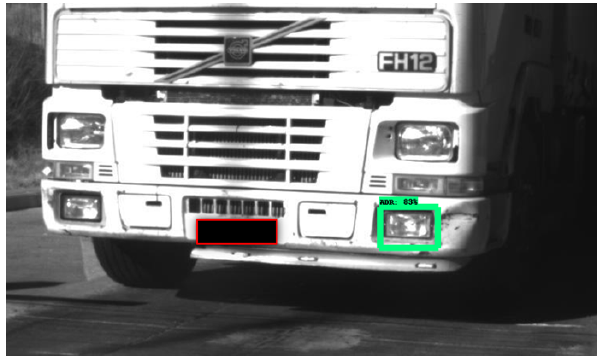
Figure 8. Non-ADR sign, from the dataset of the 200 non-ADR images, mistakenly taken as an ADR ROI (green image box).